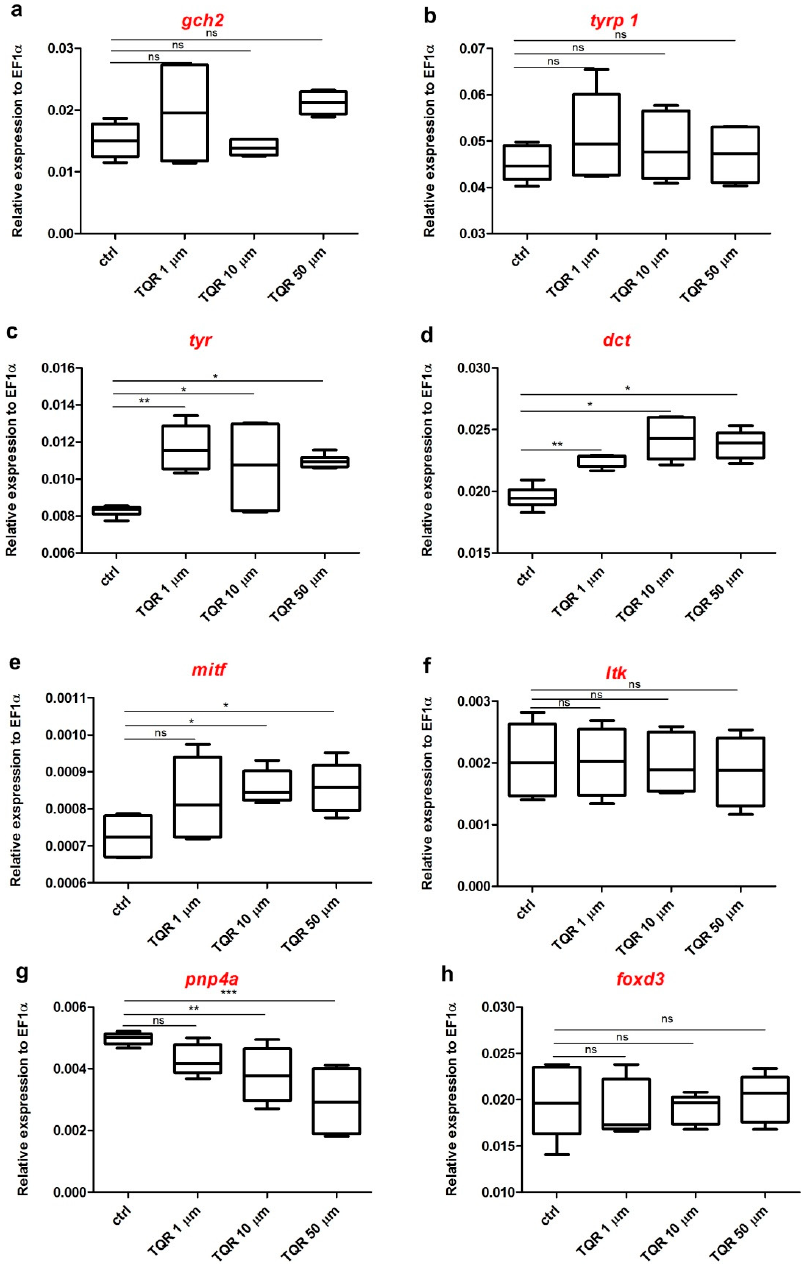
Figure 6. Expression profiles of chromatophore differentiation genes. The graphs show pooled data of the mRNA expression of ( a ) GTP cyclohydrolase 2 ( gch2 ), ( b ) tyrosinase-related protein 1 ( tyrp1 ), ( c ) tyrosinase ( tyr ), ( d ) dopachrome tautomerase ( dct ), ( e ) melanocyte inducing transcrip- tion factor ( mitf ), ( f ) leukocyte tyrosinase kinase ( ltk ), ( g ) purine nucleoside phosphorylase 4a ( pnp4a ), and ( h ) forkhead box D3( foxd3 ) from pooled 56-hour post-fertilization (hpf) wild-type zebrafish larvae ( n = 30) in four experimental groups: 1) control, 2) exposed to TQR 1 µM, 3) ex- posed to TQR 10 µM, and 4) exposed to TQR 50 µM. Each group was covered by samples ana- lyzed in triplicate in three separate experiments. Data in a figure represent the average of the three